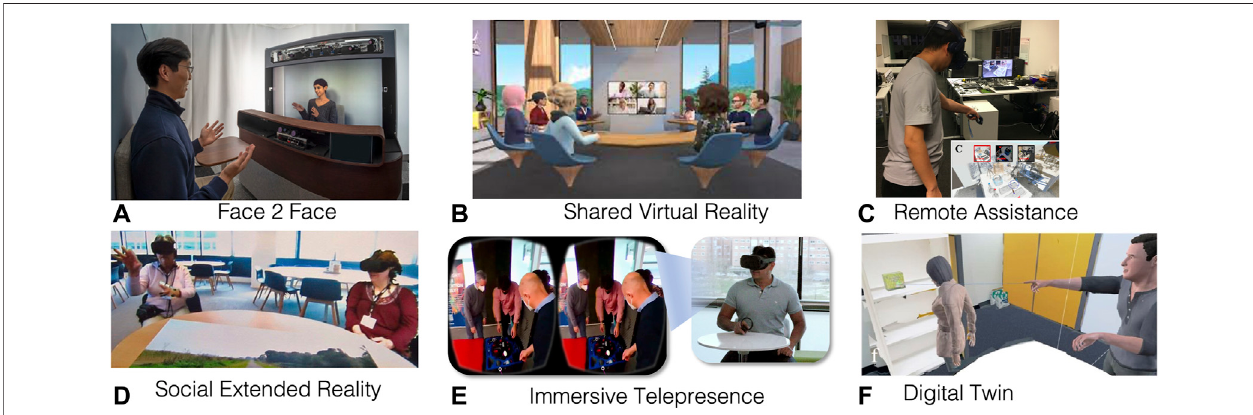
FIGURE4| Representativeexamplesfromthedifferentimmersivecommunicationarchetypes: fromtoptobottomandlefttoright: (A) GoogleStarlinebyforFace- to-face window \citep{starline}, (B) Horizon Workrooms by Meta for Shared Virtual Reality, (C) Remote Collaboration for Remote Assistance Gao et al. (2018), (D) VR Together for Social Extended Reality Prins et al. (2018), (E) The Owl for Immersive Telepresence Kachach et al. (2021), and (F) Mini me for Digital Twin Piumsomboon et al. (2018).